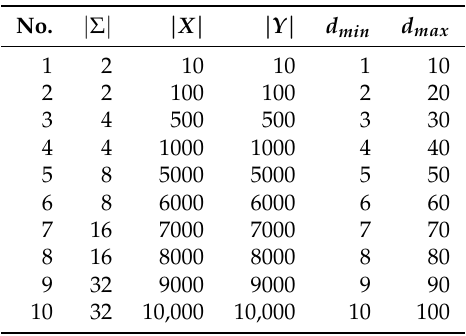
Table 1. The settings of the generator of random input for our PEG algorithm.